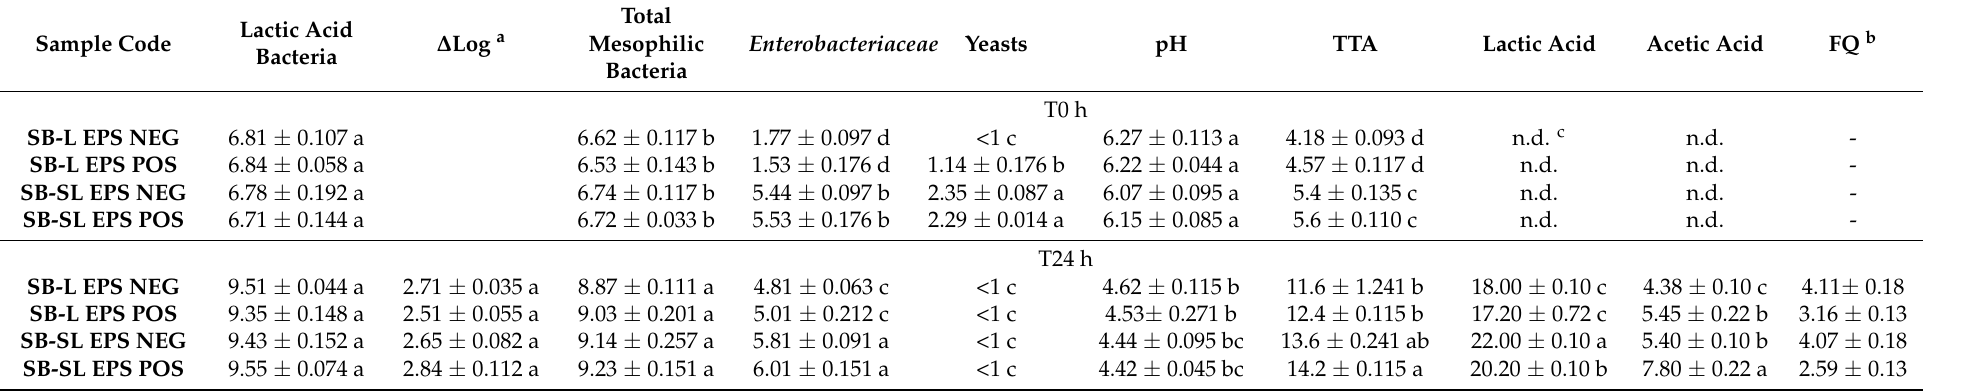
Table 1. Microbial growth and acidification 1 of control (EPS NEG) and sucrose-supplemented (16% of flour weight) doughs (DY 333) before and after 24 h of fermentation at 20 ◦ C started by Leuconostoc pseudomesenteroides DSM 20193 (initial cell density of ca. 7 log cfu/g). The table shows microbial cell density (log cfu/g) of LAB, total mesophilic bacteria, Enterobacteriaceae and yeasts, pH, TTA (mL), lactic acid and acetic acid concentrations (mmol/Kg dough) and their ratios (FQ). SB-L EPS NEG, sprouted barley-raw lentil dough (30:70 ratio); SB-L EPS POS, sucrose-supplemented sprouted barley-raw lentil dough (30:70 ratio); SB-SL EPS NEG, sprouted barley–sprouted lentil dough (30:70 ratio); SB-SL EPS POS, sucrose-supplemented sprouted barley–sprouted lentil dough (30:70